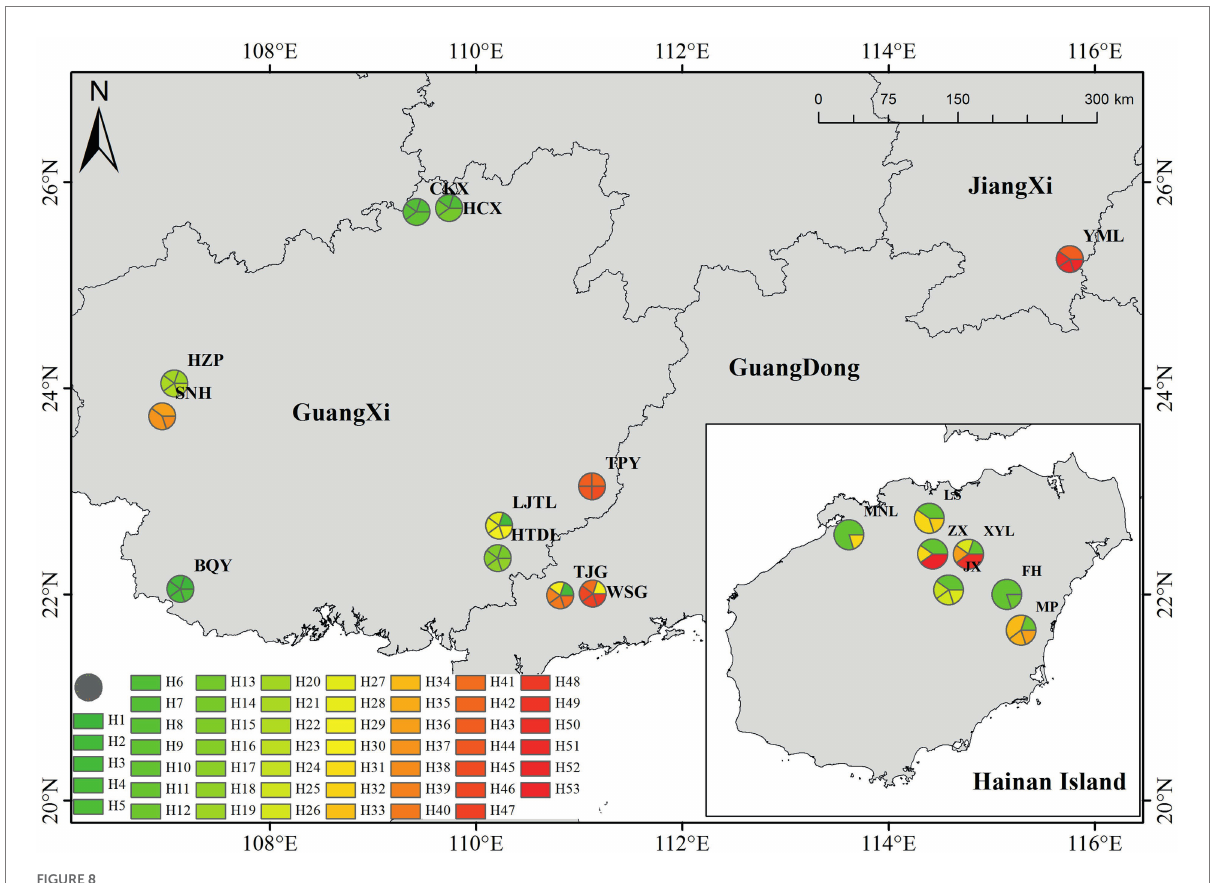
FIGURE 8 Distribution of cpDNA haplotypes in 53 ribotypes of the test